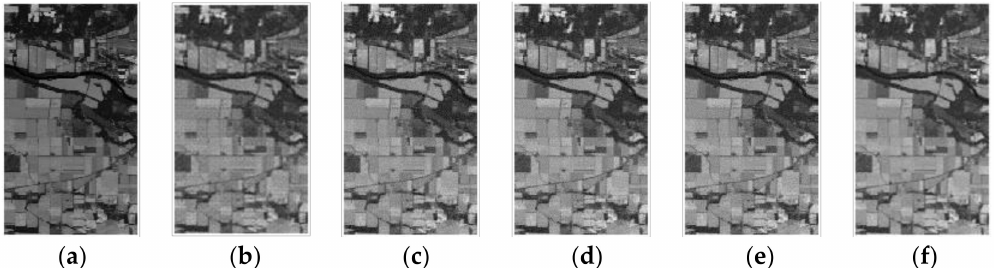
Figure 4. The original image and reconstructed image with band number 180, the compressed sensing algorithm is based on the TIPML algorithm, ( a )The original images; ( b ) The sampling rate of the reconstructed image is SR = 0.1; ( c ) The sampling rate of the reconstructed image is SR = 0.2; ( d ) The sampling rate of the reconstructed image is SR = 0.3; ( e ) The sampling rate of the reconstructed image is SR = 0.4; ( f ) The sampling rate of the reconstructed image is SR = 0.5.